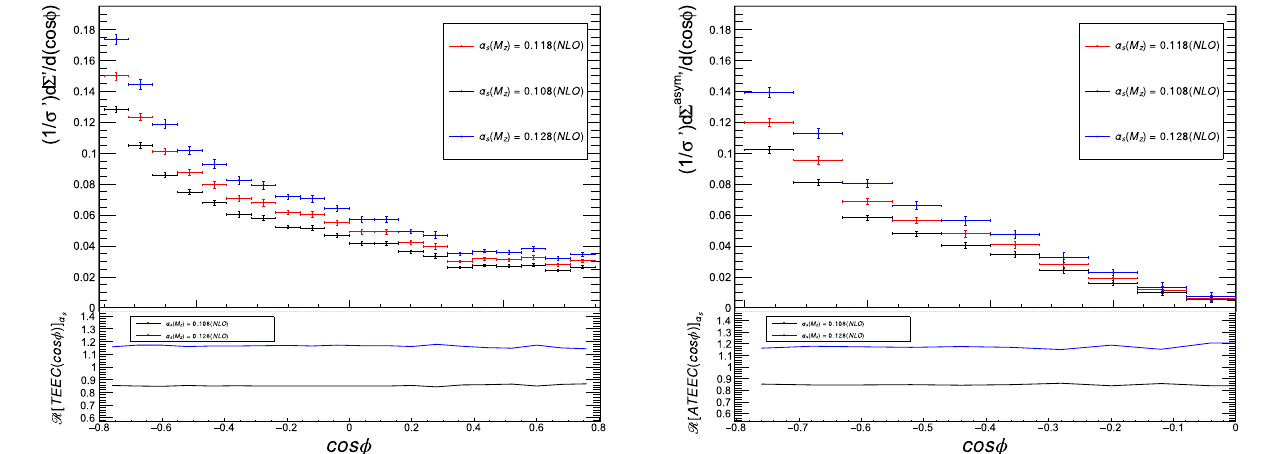
) for three indi- Z